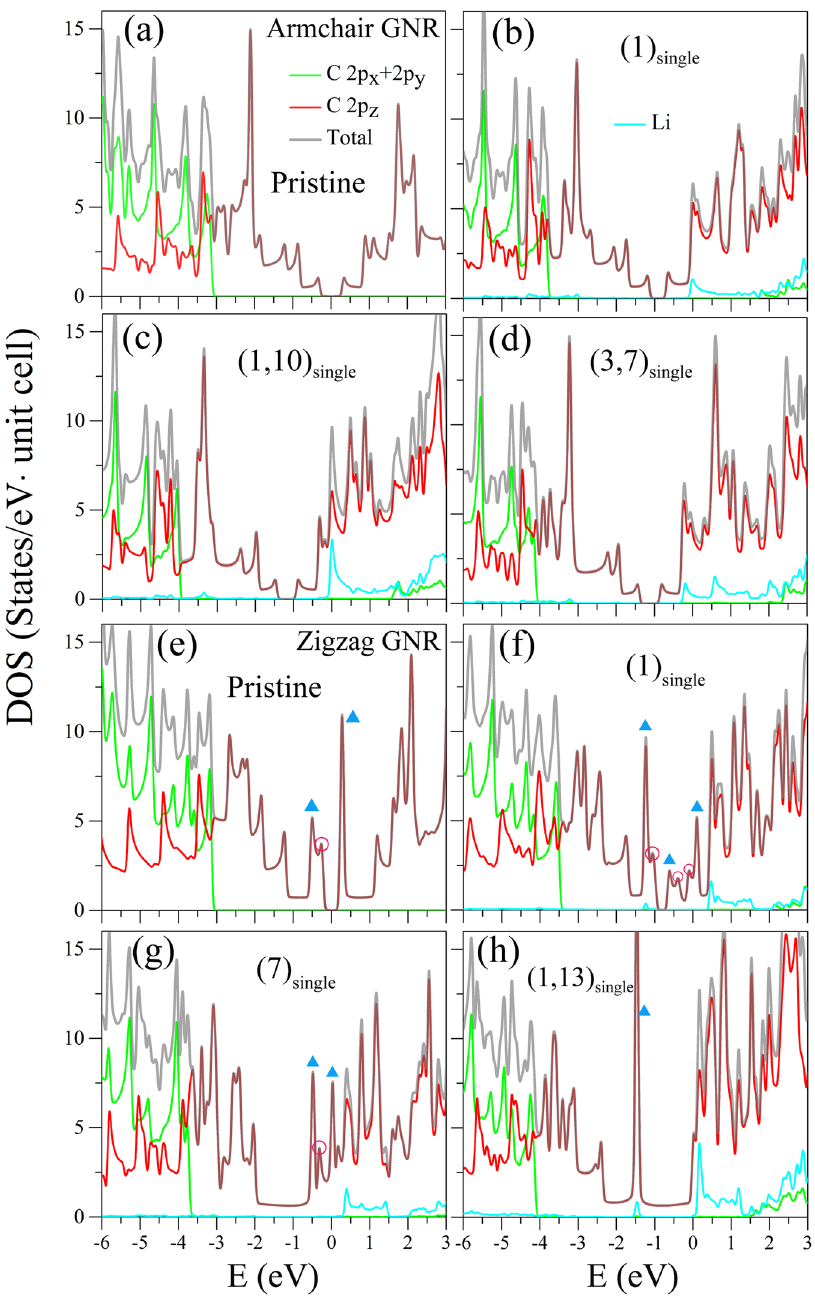
Figure 6. The total and orbital-projected DOSs of N A = 12 armchair systems for ( a ) a pristine GNR, ( b ) an adatom at edge (1) single , and the double-side adsorptions of ( c ) two adatoms at (1, 10) single and ( d ) (3, 7) single . Those of N Z = 8 zigzag systems are shown for ( e ) a pristine GNR, and the Li adsorptions situated at ( f ) (1) single , ( g ) a ribbon center (7) single and ( h ) two edges (1, 13) single